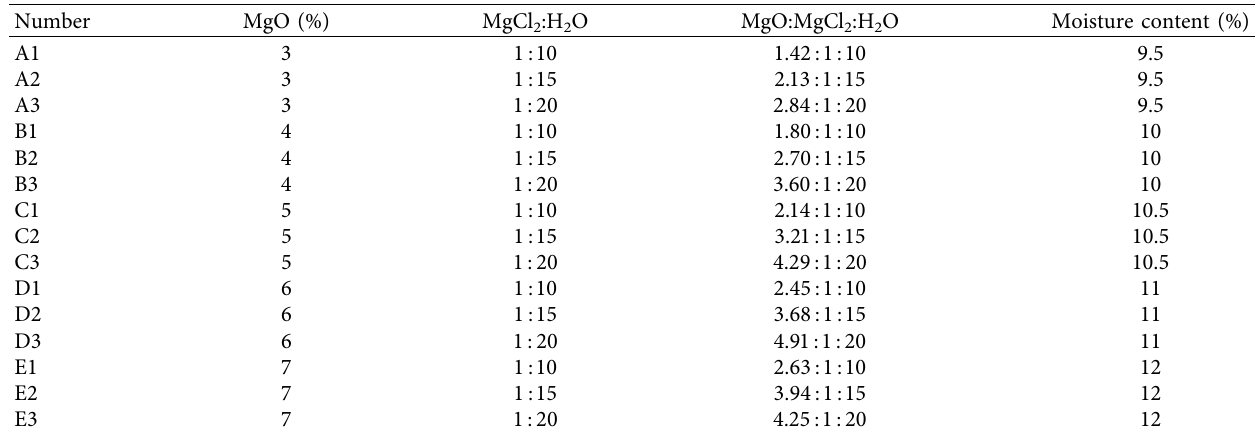
Table 4: MOC raw material